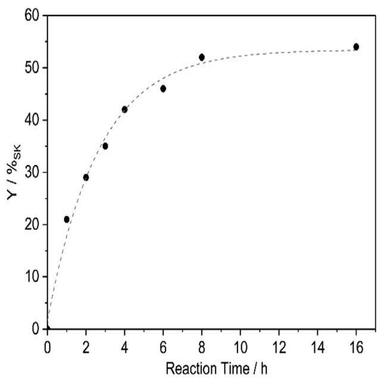
Kinetic study performed using Ga-74 catalyst. Reaction conditions: 10 mg of catalyst, 0.01 mol of glycerol, 0.04 mol of acetone, 50 C.